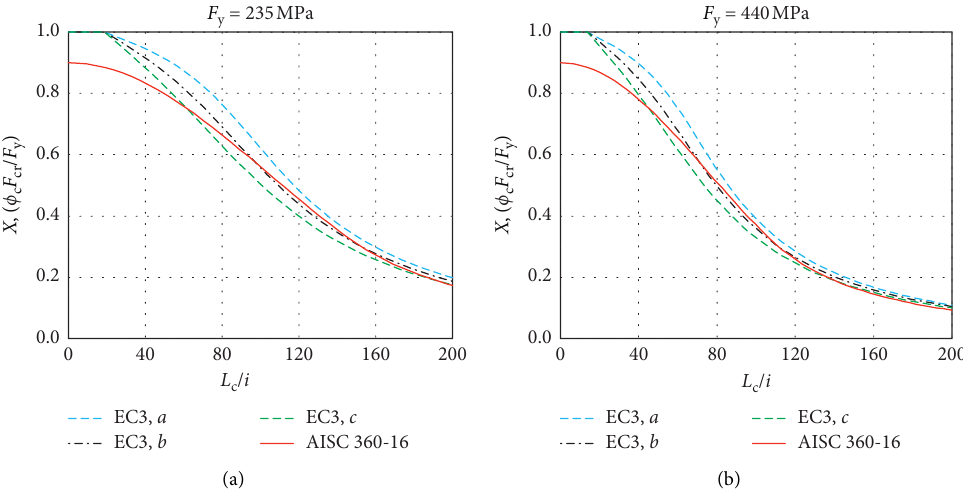
Figure 4: Buckling curves plotted as a function of member slenderness ( L